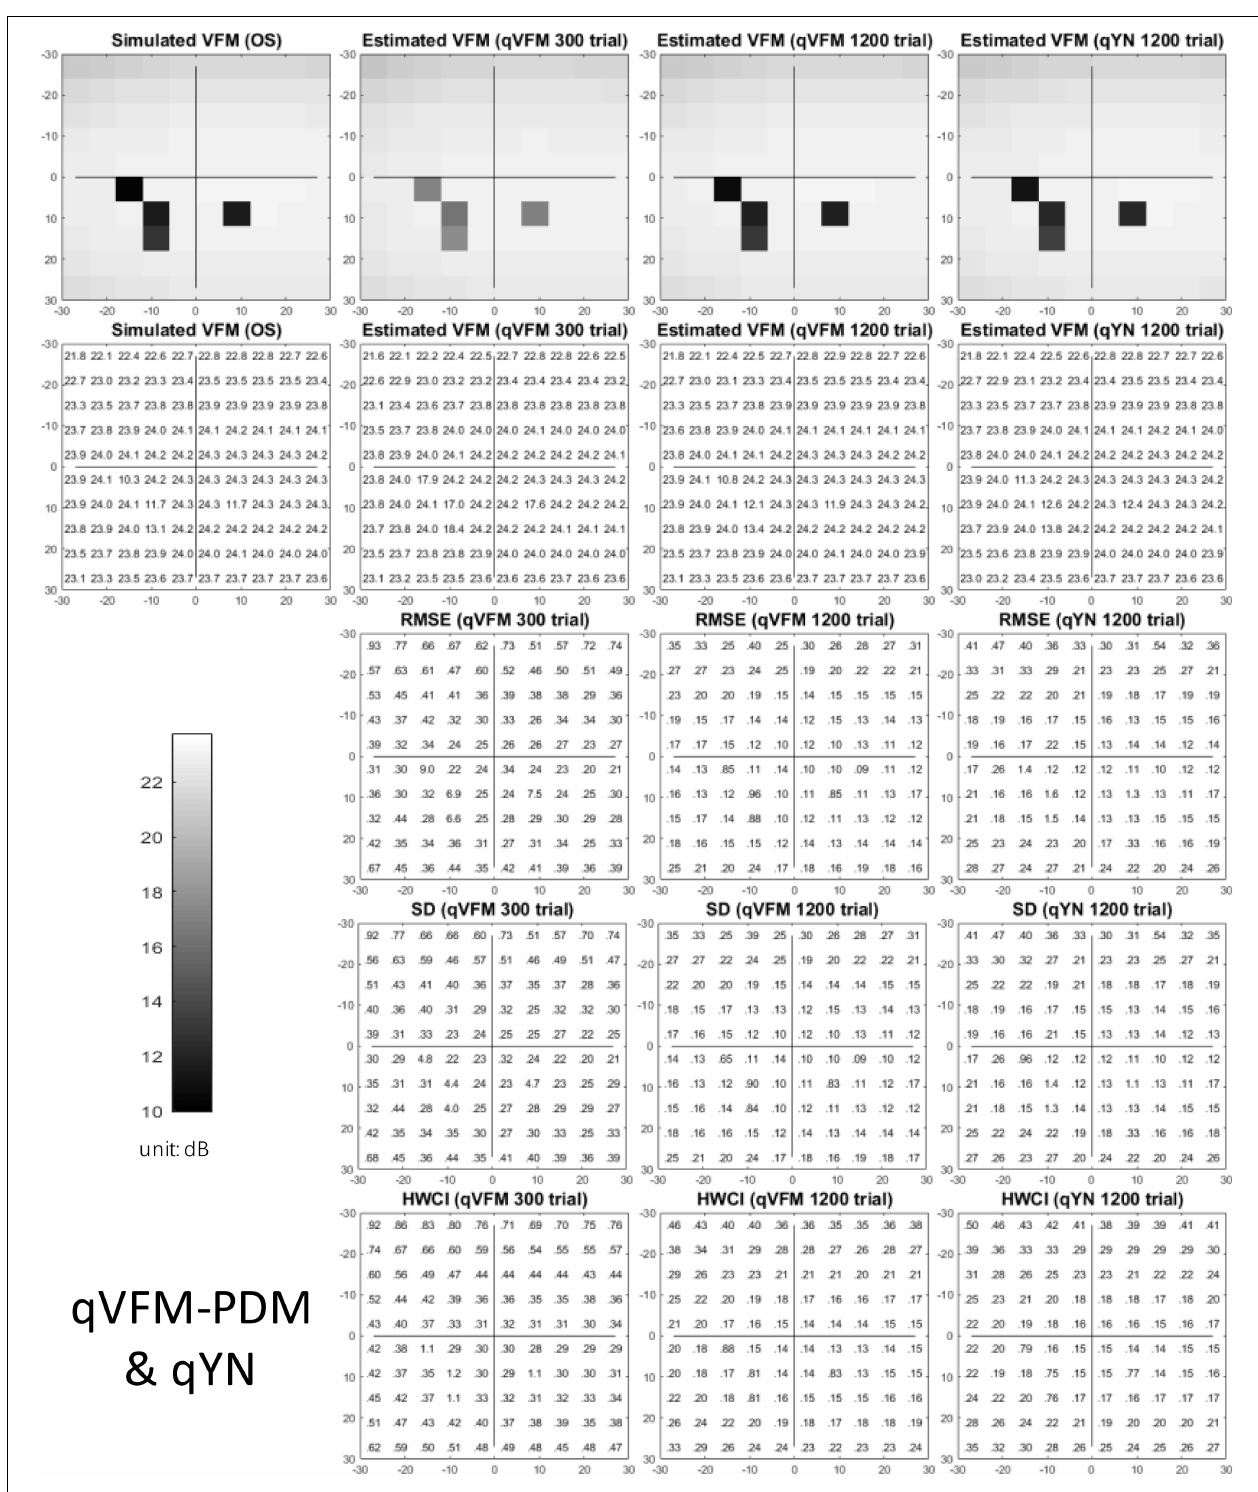
FIGURE 2 | Simulation results I of the scotoma observer across 200 runs. The true VFM of the simulated observer (monocular) is presented in the first column of the first row with achromatic colormaps and second row with numerical values. The estimated VFMs obtained with the qVFM-PDM method after 300 trials and 1,200 trials, qYN method after 1,200 trials are presented in the first and second rows, respectively. The corresponding RMSE, SD, and 68.2% HWCI of the estimates are in the third, fourth, and fifth rows.